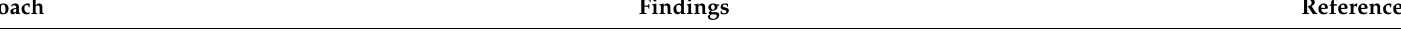
Table 1. Experimental therapy strategies employed in mouse models of pulmonary fibrosis induced by Paracoccidioides brasiliensis infection.